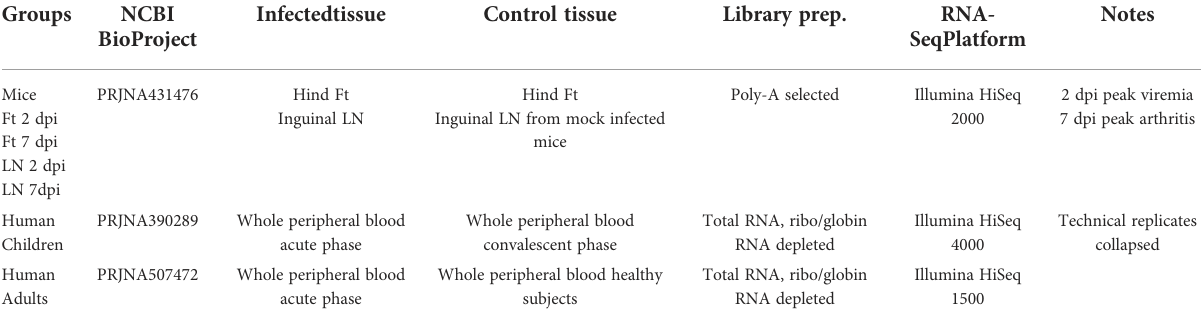
TABLE 1 Origins of human and mouse gene expression datasets.